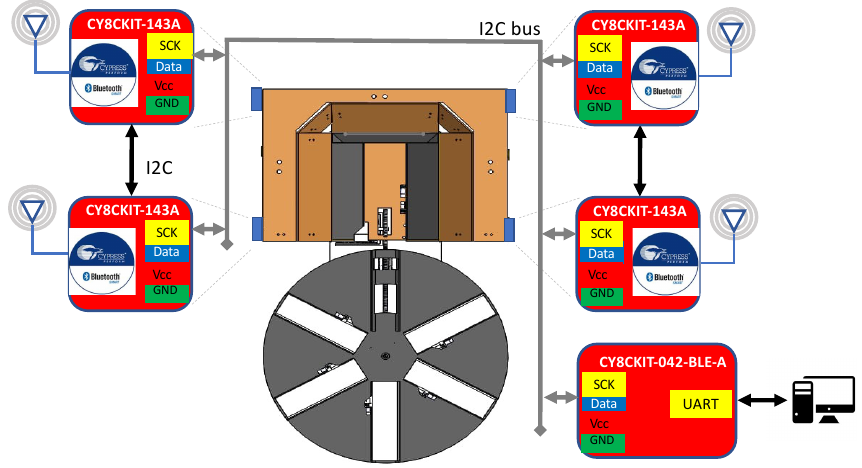
Figure 6. Schematic design of the HW sensing ground